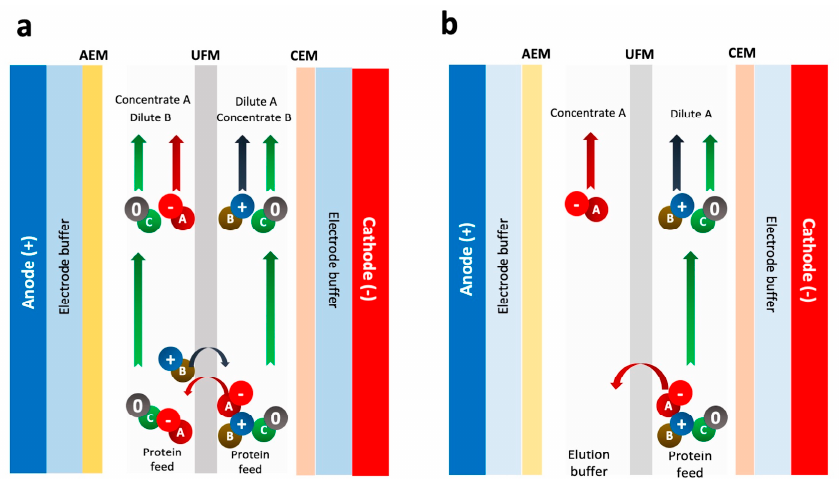
Figure 2. Electrodialysis with UF membrane (EDUF) in ( a ) separation and ( b ) elution mode. CEM: cation-exchange membrane; AEM: anion-exchange membrane; UFM: UF membrane. cation-exchange membrane; AEM: anion-exchange membrane; UFM: UF